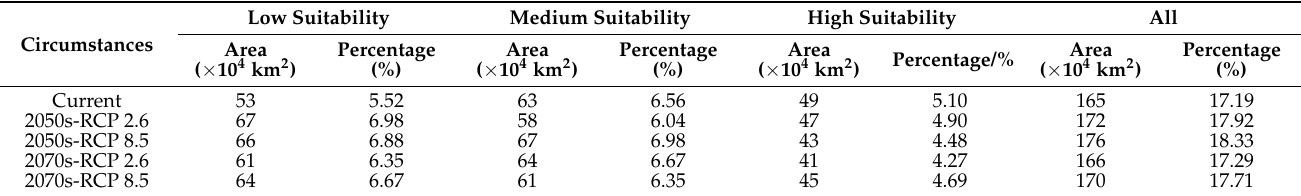
Table 4. Area statistics of suitable areas for Q. spinosa under different climate